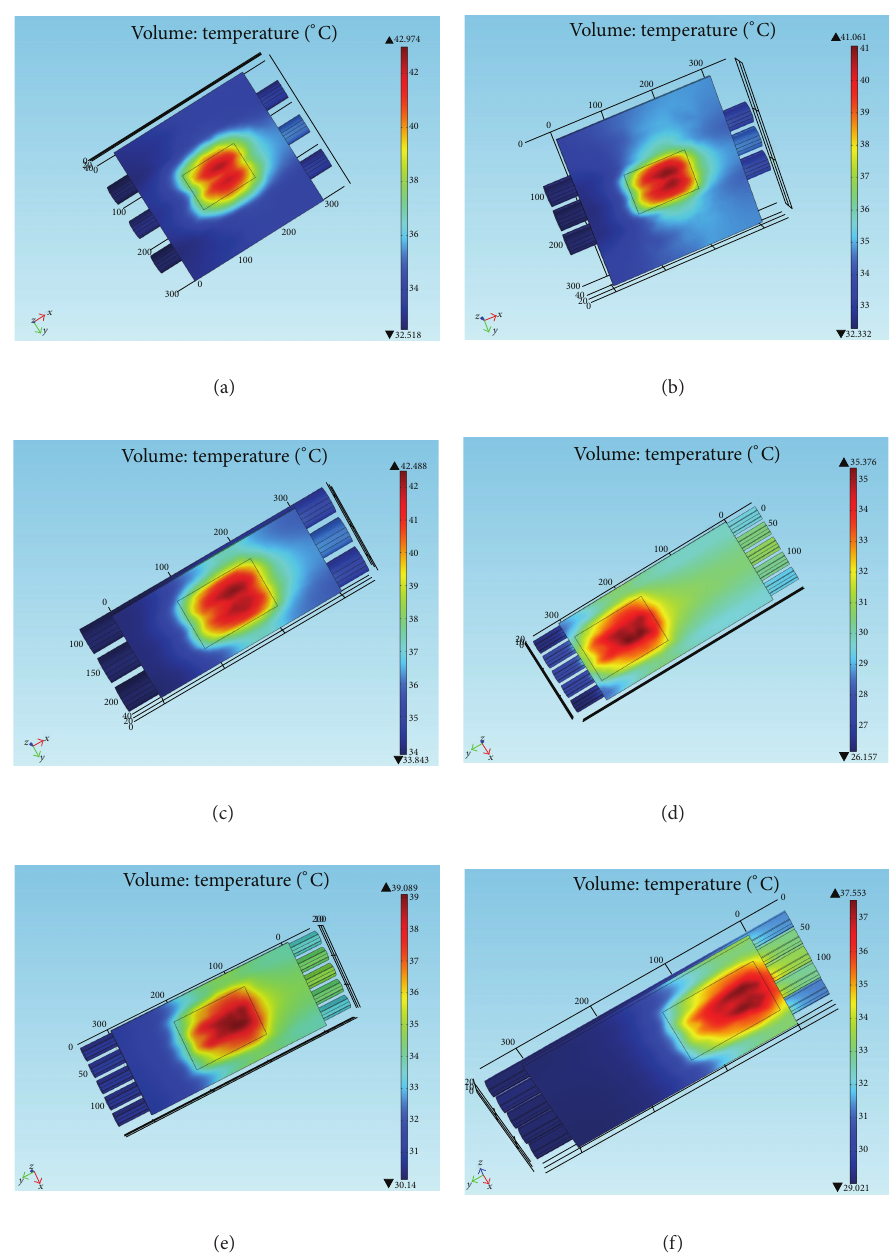
Figure 3: Computer simulations for different configurations (see text); the colors show the temperature